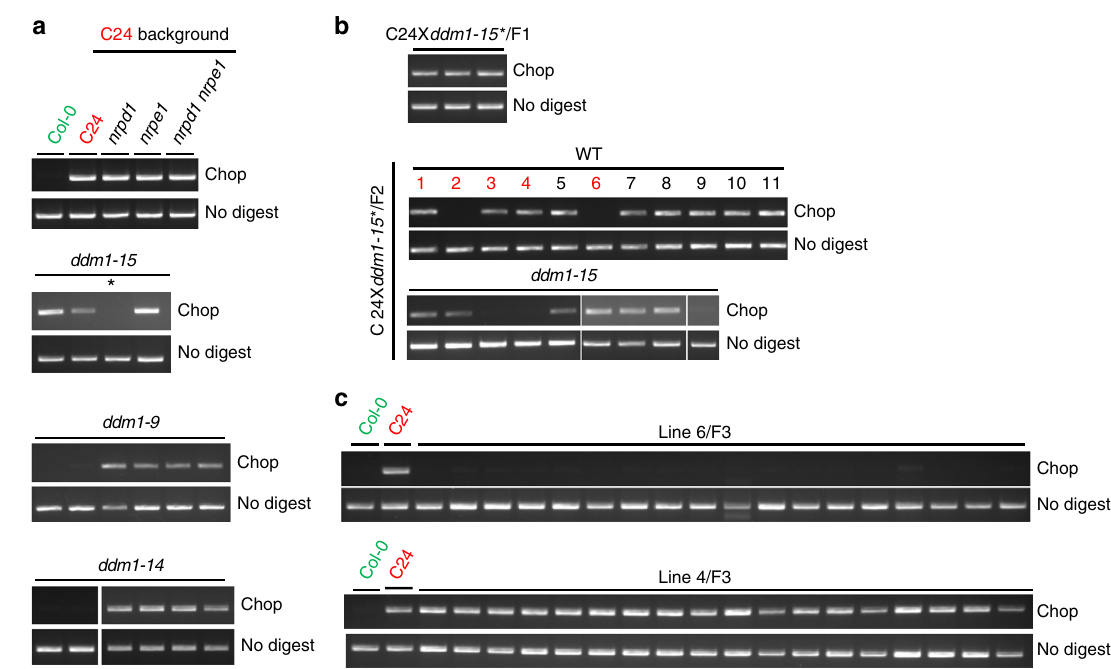
Fig. 4 Stochastic and unrecoverable loss of methylation of NMR19-4 in ddm1 -mutant plants. a DNA methylation of NMR19 in different mutants in C24 background. Asterisk denotes that the individual plant was used for backcross with C24 in the following analysis. b Methylation patterns of NMR19-4 in F1, F2 progenies of backcross. WT, the F2 individual plant without ddm1 mutation; ddm1-15 , F2 individual plant with homozygous ddm1-15 mutation; the red colored numbers indicate the offspring of these lines used for F3 analysis in c and (Supplementary Fig. 9b). c Methylation status of NMR19-4 in F2 is maintained in F3